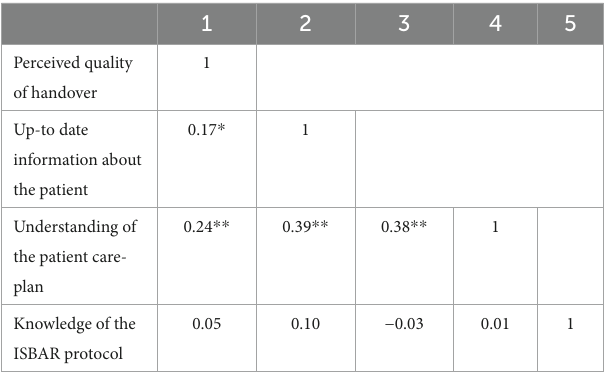
TABLE 2 Bivariate correlations between